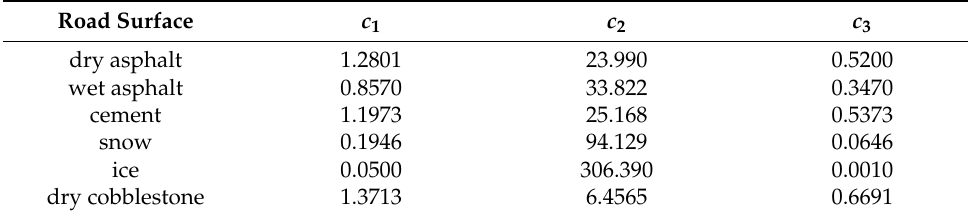
Table 2. The Burckhardt model parameters under different road surfaces. Road Surface